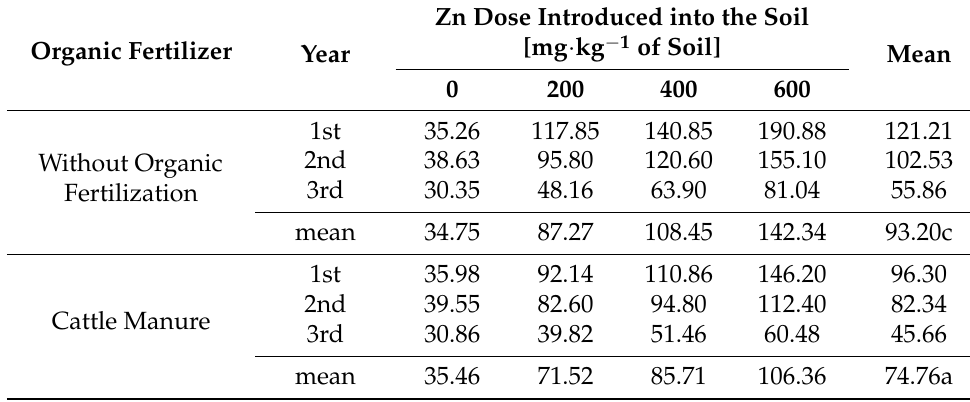
Table 5. The content of zinc in cocksfoot (mg Zn kg − 1